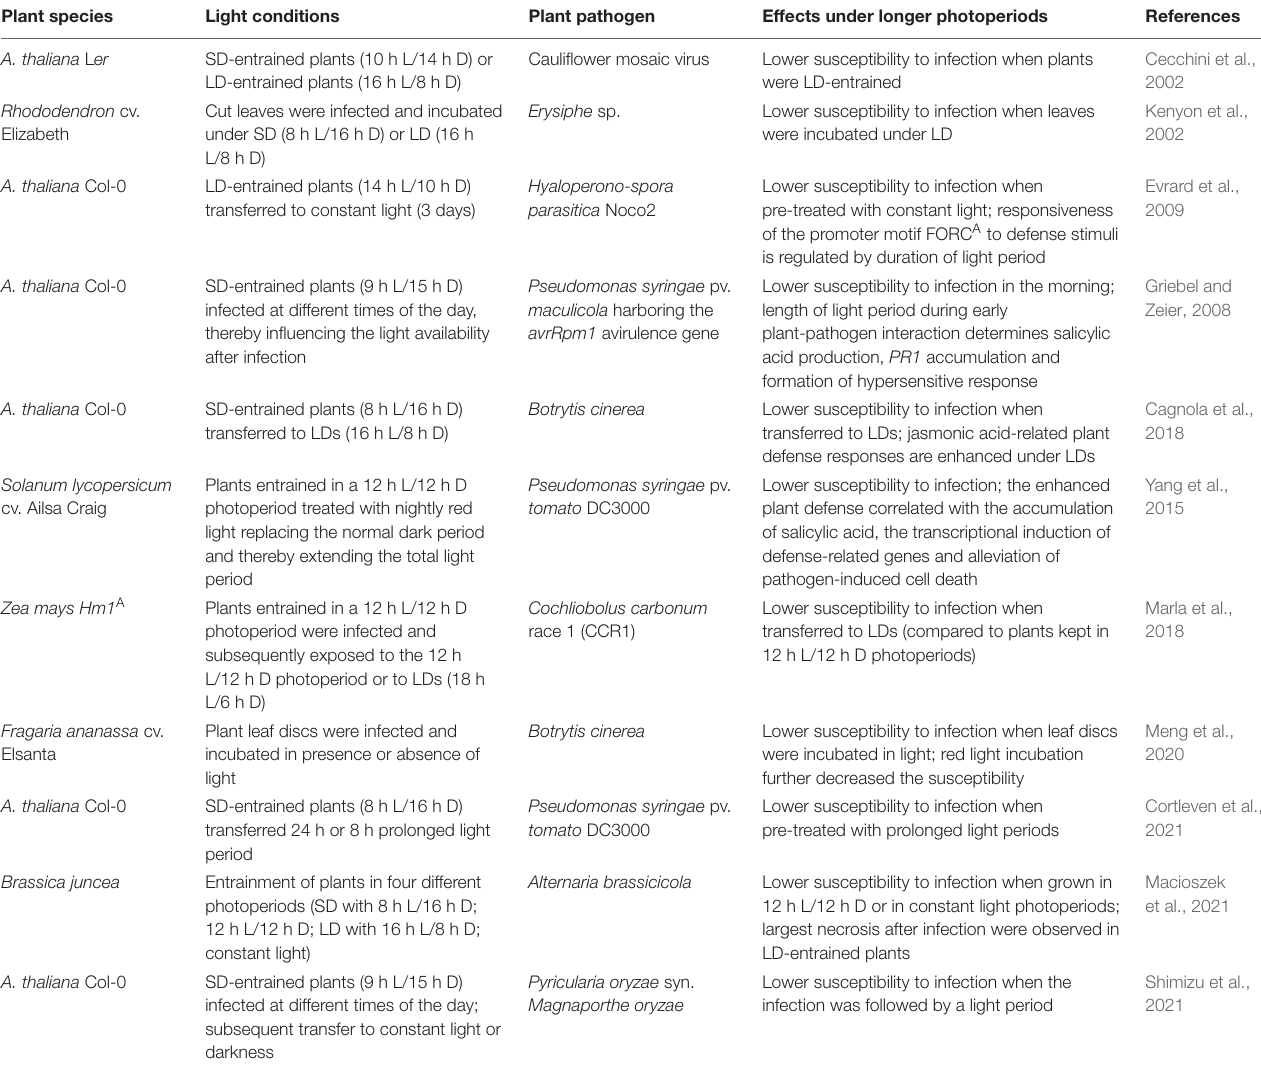
TABLE 1 | The photoperiod affects in plants the response to biotic